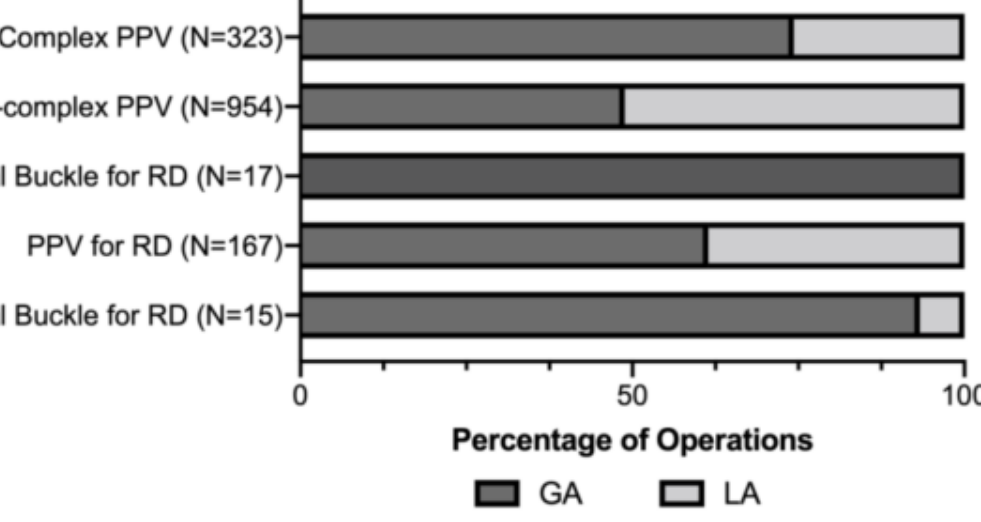
Figure 2. Graph showing the type of anesthesia used according to the complexity of the vitreoretinal surgery. Table 2. Adjusted Odds Ratios for Performance of Vitreoretinal Surgery Type Under General An- esthesia.